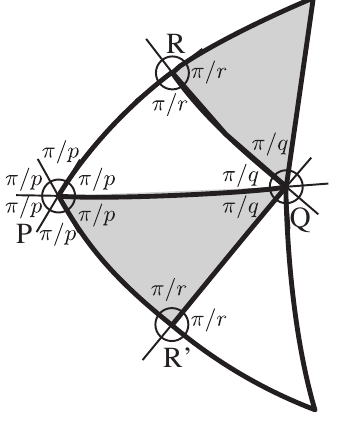
Fig. 3 Schematic illustration of a part of a Coxeter print Figure 4. Schematic illustration of a part of a Coxeter print { p , q , r }.